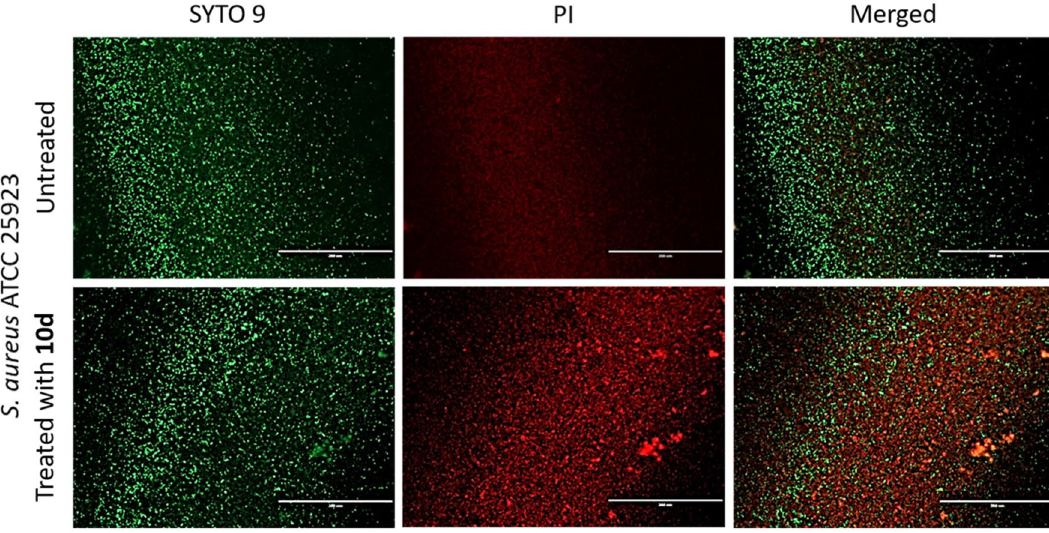
Figure 6. Fluorescence microscopy images of 18-h old S. aureus ATCC 25923 biofilms in a 96-well plate exposed to 10d at 100 µM for 24 h. Representative images of biofilms stained with LIVE/DEAD BacLight kit are displayed. Scale bars correspond to 200